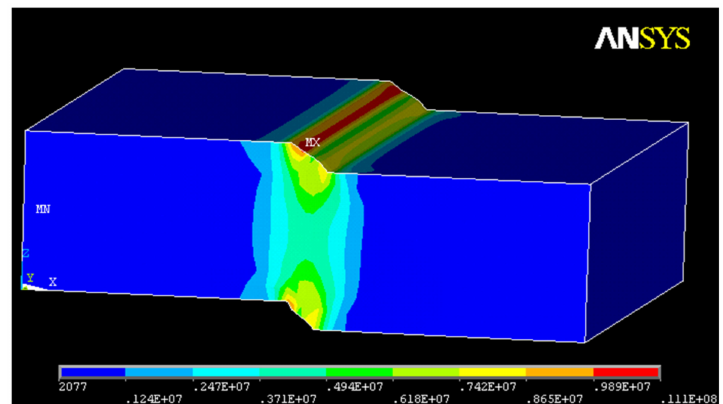
Figure 11. Finite element mesh (deformed).